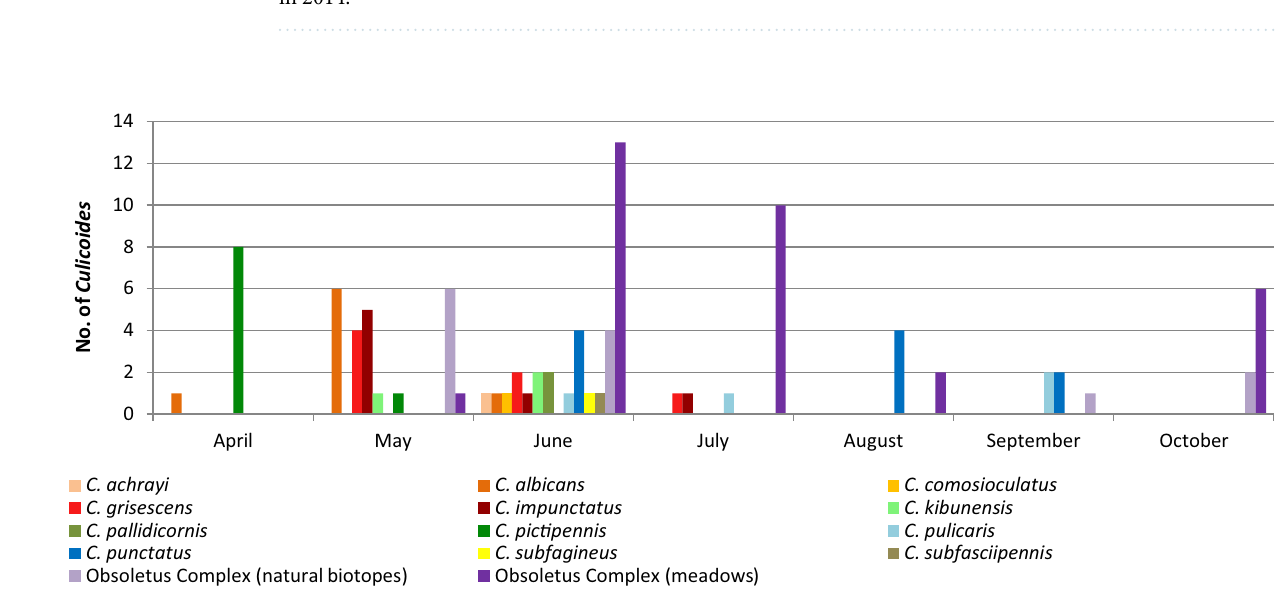
Table 7. Biodiversity indices of Shannon–Weaver, Evenness and Simpson index. Index numbers and calculated biodiversity indices of Shannon–Weaver index and Simpson index based on Culicoides spp. collected in 2014.